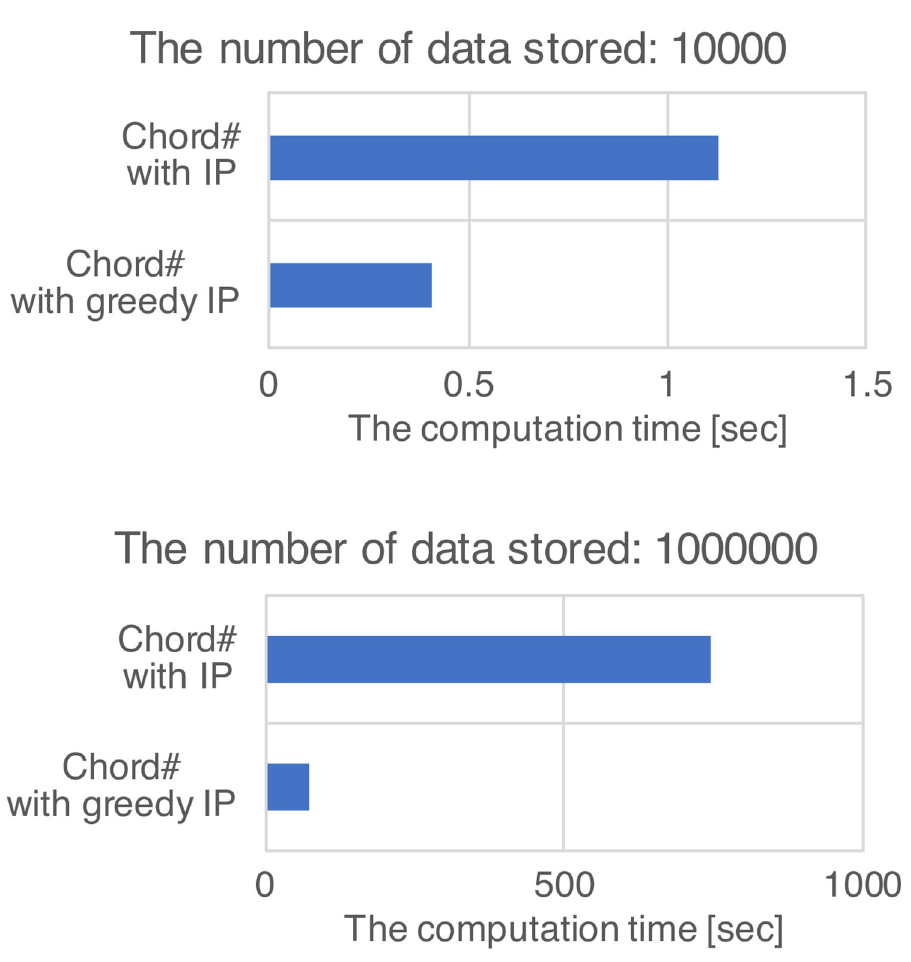
Fig 9. Reduction of the computation time by the greedy